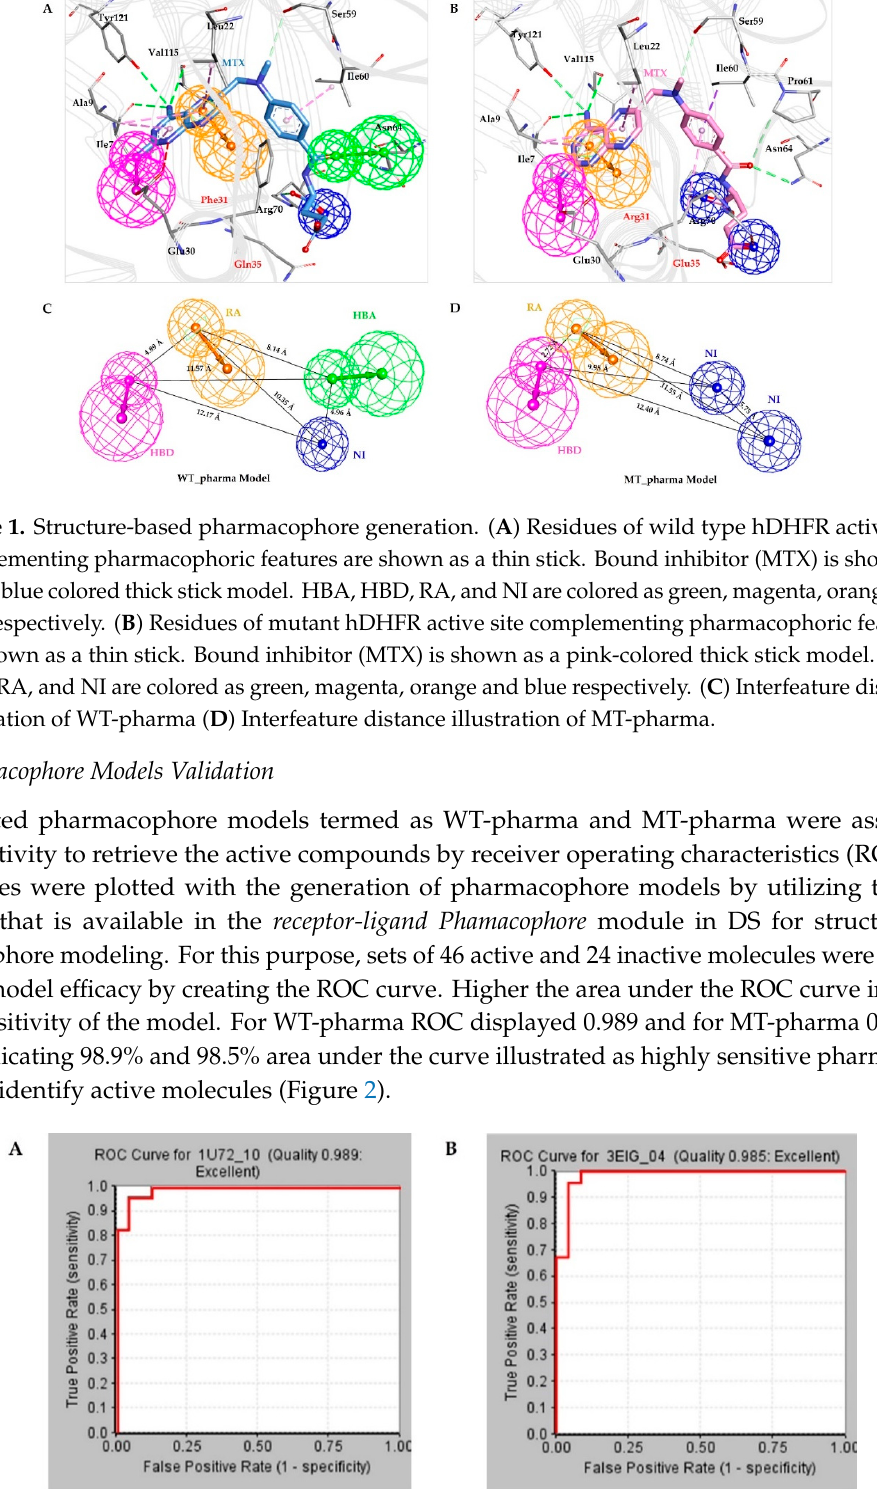
Figure 2. Receiver Operating Characteristics curves for validation of selected pharmacophore models between true positive and false-positive rates. ( A ) ROC curve shown in the red line for the WT-pharma model with 0.989 curve quality depicts 98.9% area under the curve. ( B ) ROC curve shown in the red line for the MT-pharma model with 0.985 curve quality depicts 98.5% area under the